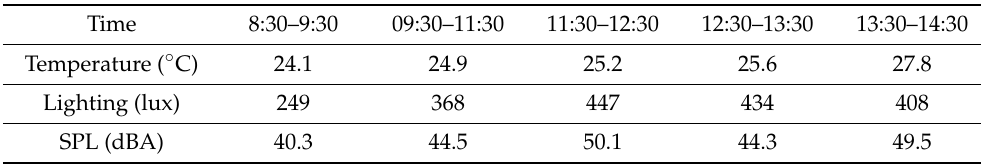
Figure 8. IEQ evaluation results of classroom 110.